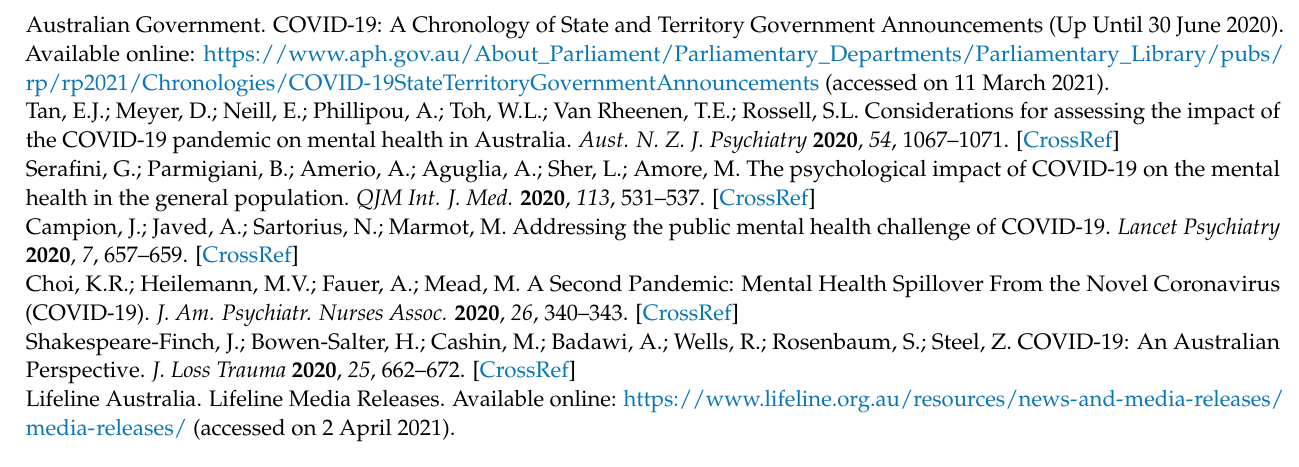
Table S3: Associations between different types of nature activities and mental health state during the COVID-19